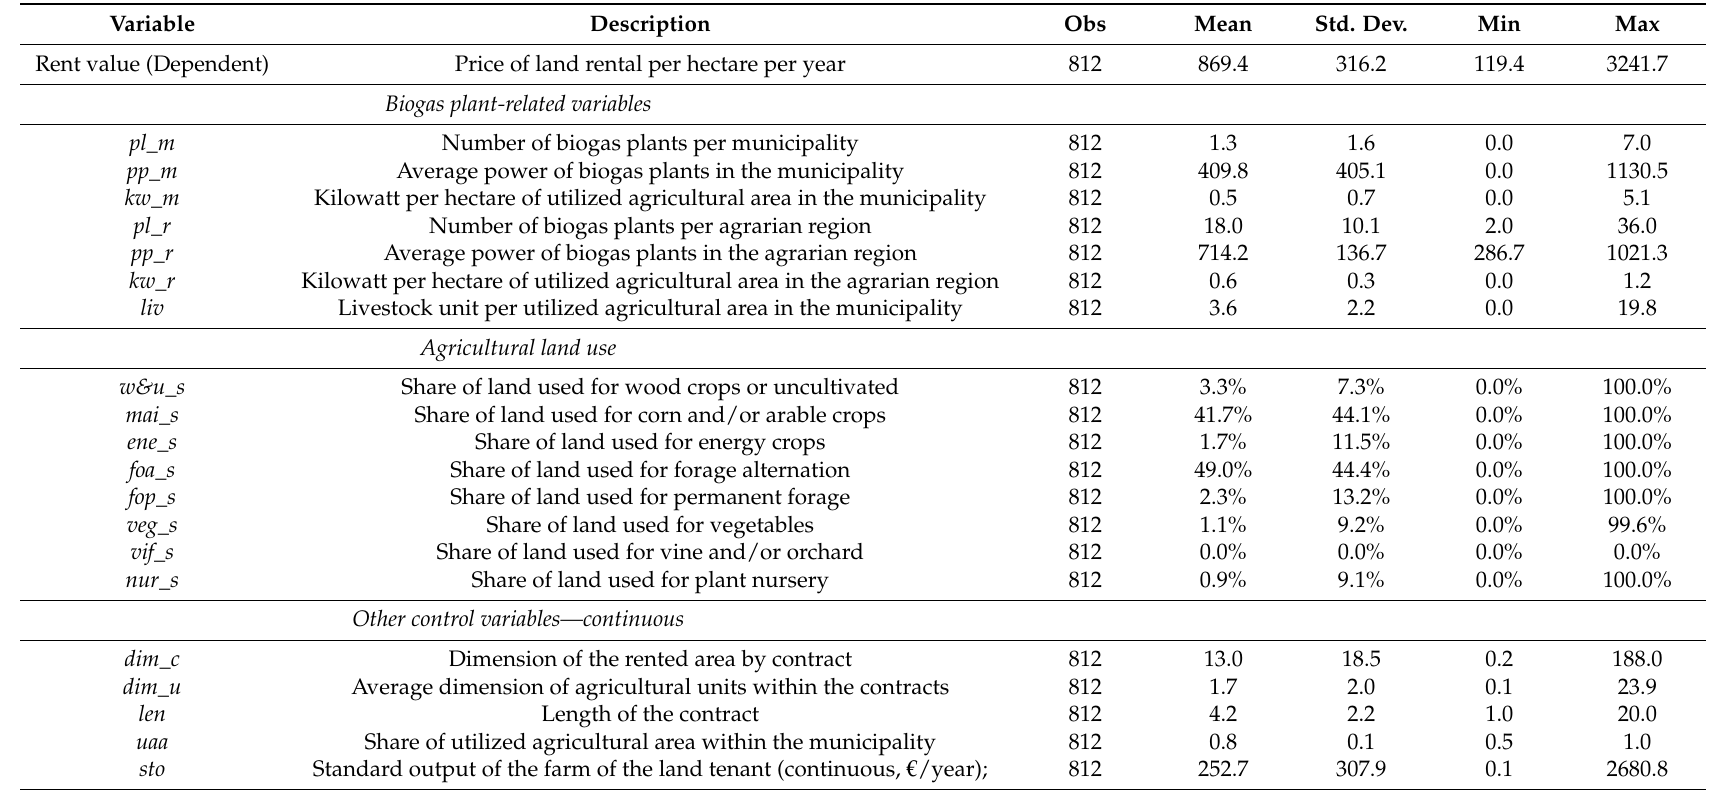
Table C1. Descriptive statistics of continuous variables in regression